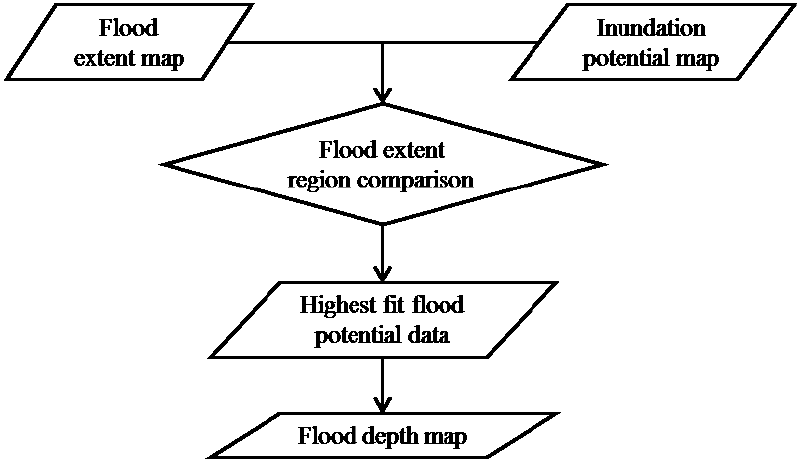
Figure 8. The flowchart of inferring the flood depths by combining flooding patterns with the inundation potential maps produced by WRA from 2007 to